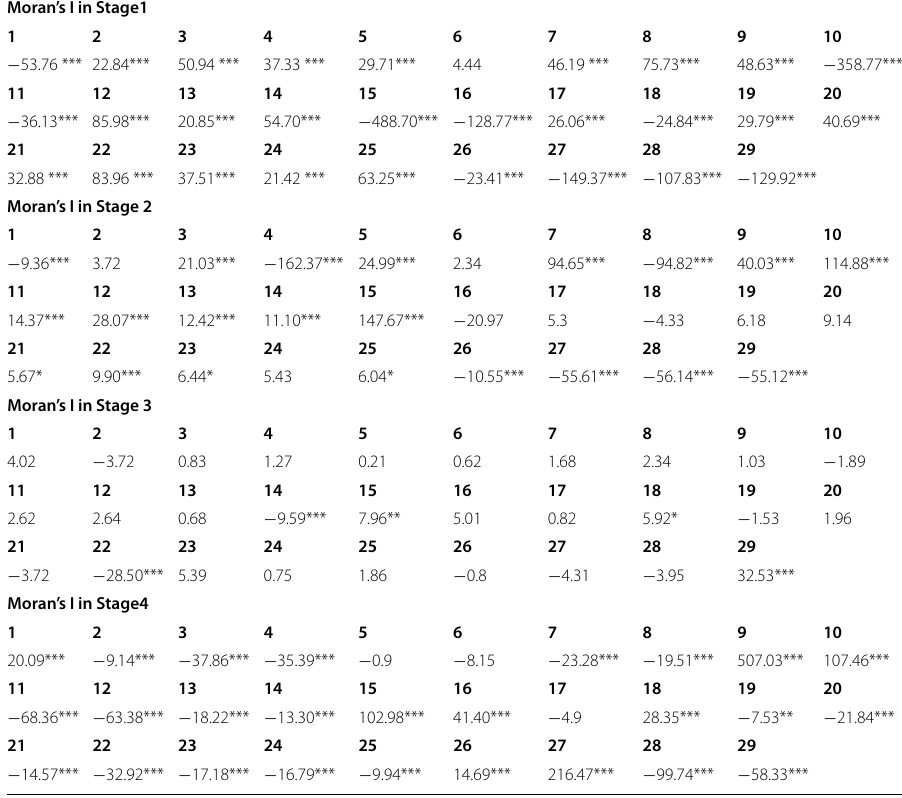
***, **, * represent the significance levels at 1%, 5% and 10%, respectively